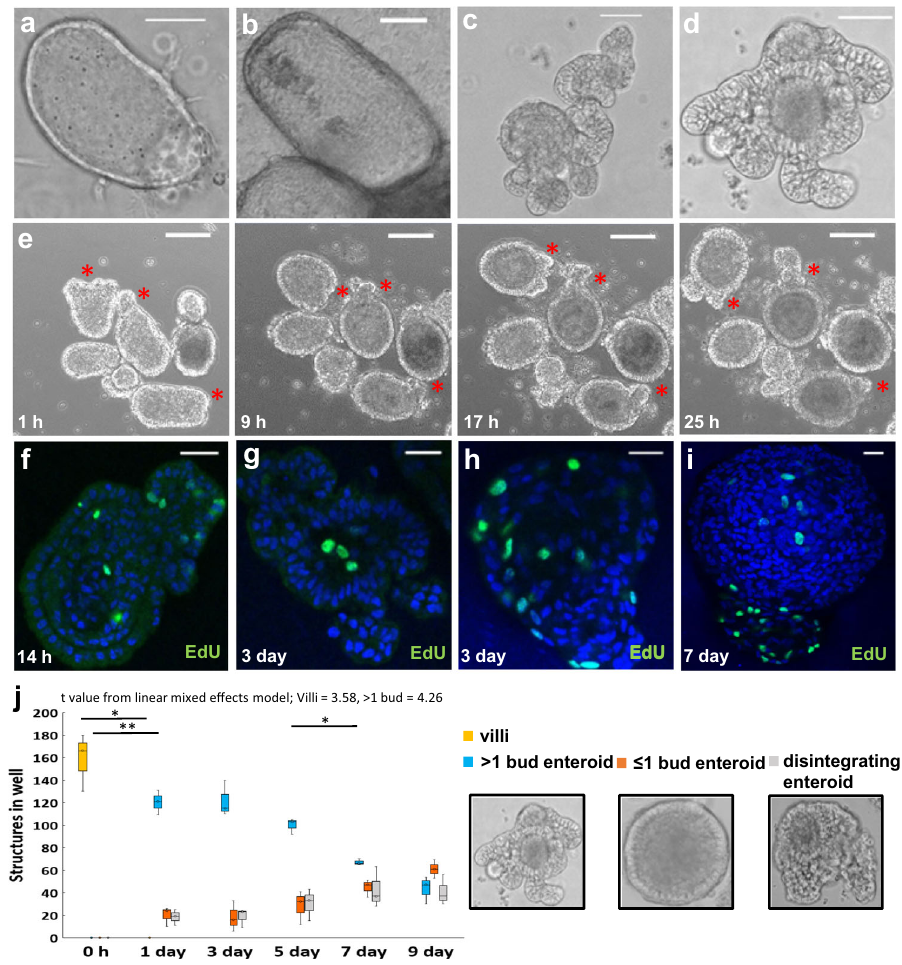
Fig. 1 Establishment of fl oating chicken enteroids. a Matrigel-embedded embryonic chicken spheroids increase in size but lack budding at day 1 and b day 7 of culture. c Floating large multi-lobulated chicken enteroid structures develop over 3 days and d are maintained at day 9 of culture. Scale bar: 50 µ m. e Time-lapse images from Supplementary video 1 showing the formation of budding crypt-like structures (marked by star *) in fl oating embryonic enteroids. Images are representative of data from at least 20 independent cultures each containing 2 – 3 embryos. Scale bar: 100 µ m. Confocal images of fl oating embryonic enteroids showing proliferating cells (green, EdU) in both buds and core at f 14 h, g , h 3 days and i 7 days of culture. Images are representative of 3 independent cultures. Scale bar: 200 µ m. j Quanti fi cation of fl oating embryonic enteroid numbers and morphology showed a signi fi cant increase in multiple budding enteroid numbers in the fi rst day of culture. Data averaged for 3 cultures containing 2 – 3 embryos, 3 wells/culture, ~180 villi seeded per well at day 0. Villi: * t = 3.58, F = 8.07, df = 1; >1 bud enteroid: * t = 4.26, F = 0.03, df = 1 using a linear mixed effects model. Villi 0 h – 1 day: * p = 0.009, t = 10.65; >1 bud enteroid 0 h – 1 day: ** p = 0.003, t = − 18.92; >1 bud enteroid 5 – 7 day: * p = 0.008, t = 10.8 using post hoc pairwise